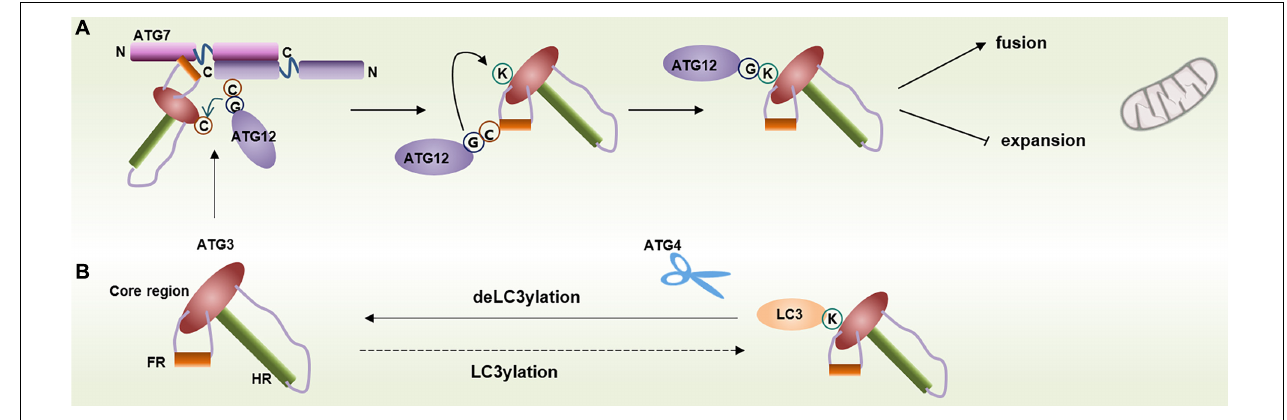
FIGURE 3 | Modification of ATG3 residue Lys243. (A) Lys243 within ATG3 can conjugate with free ATG12 and contribute to mitochondrial homeostasis. (B) Lys243 within ATG3 can also form a conjugate with LC3 via a process called LC3ylation, and ATG4 can cleave the conjugate.